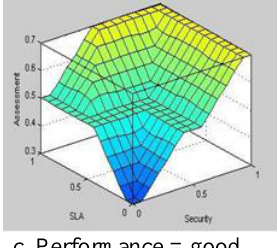
Figure 8. Evolution of trust with respect to neutral user